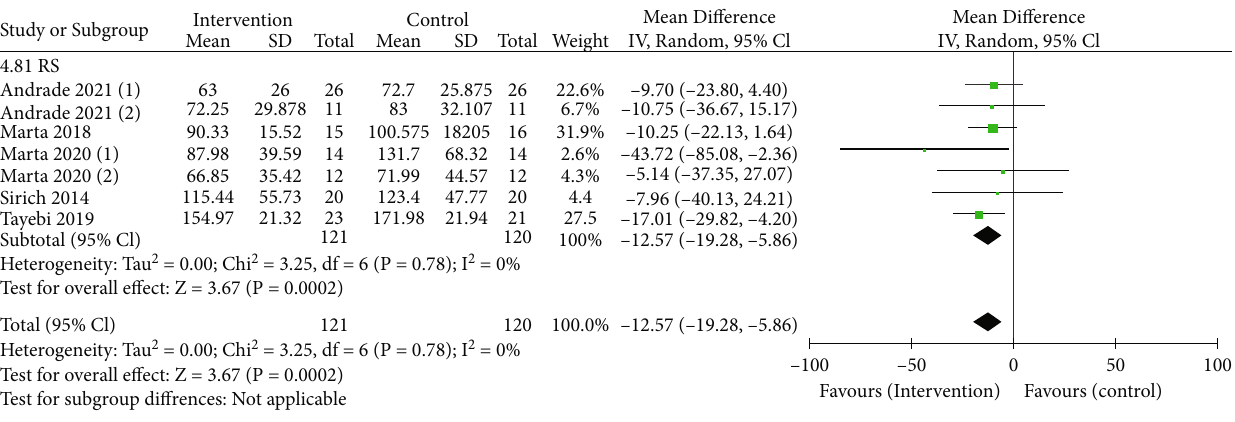
Figure 3: Pooled estimated e ff ect of RS intake on IS ( μ mol/L) in patients with CKD, with estimated MD and 95% CIs.